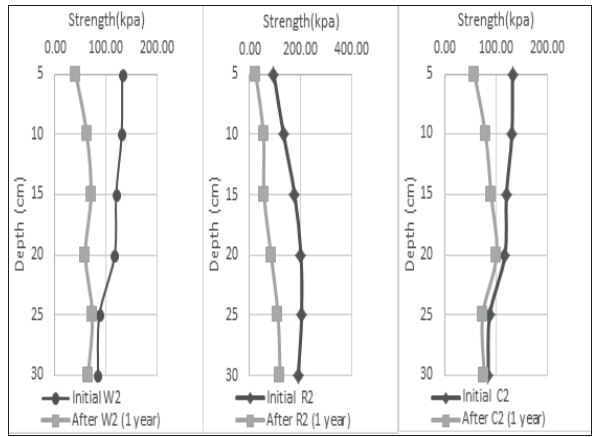
Figure 10. Soil strength at different depths before and one year after establishing the cover crops and trees in three farmers sites in Santo Tomas,